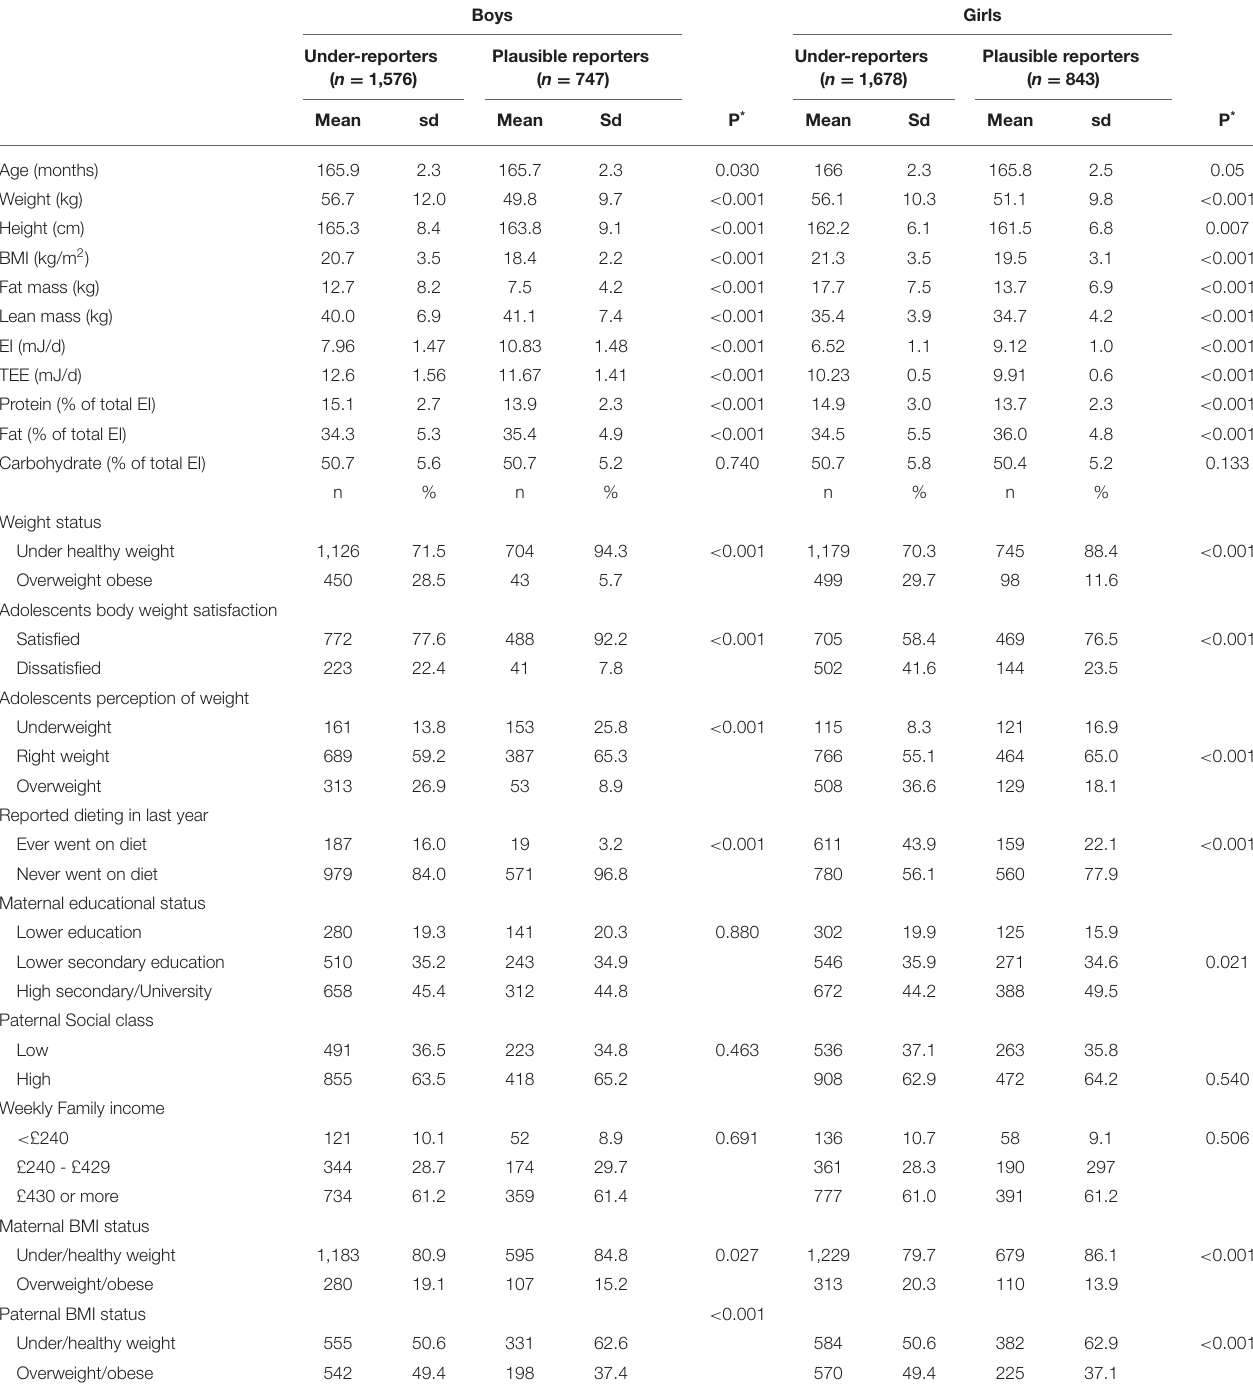
TABLE 2 | Descriptive characteristics of 13-year-old adolescents by sex and dietary energy reporting group.